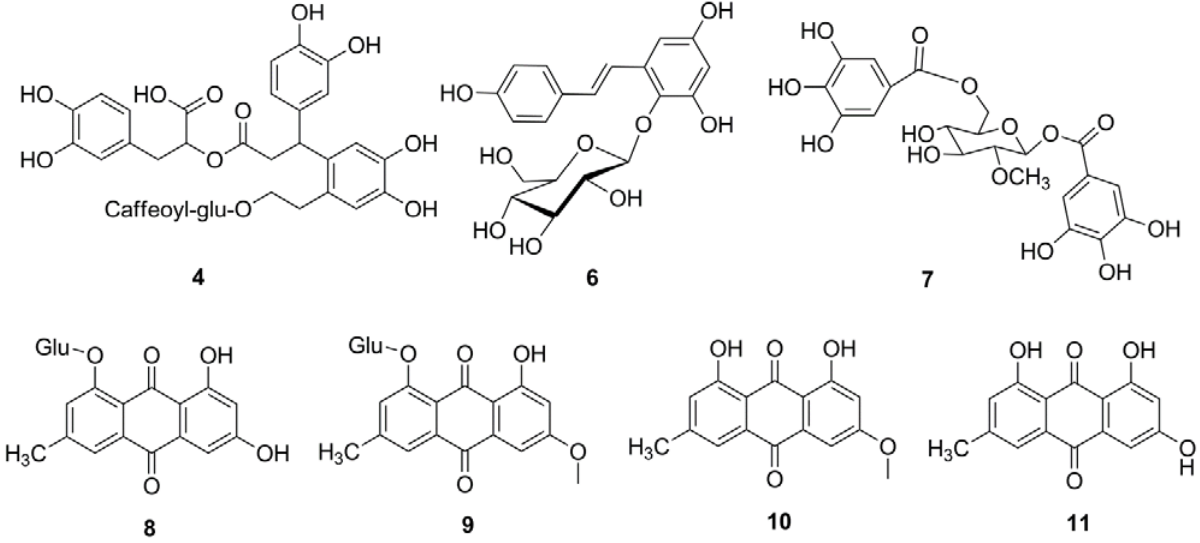
Figure 2. Structures of phenolic compounds identified in P. multiflorum Thunb. G, galloyl group; Glu,